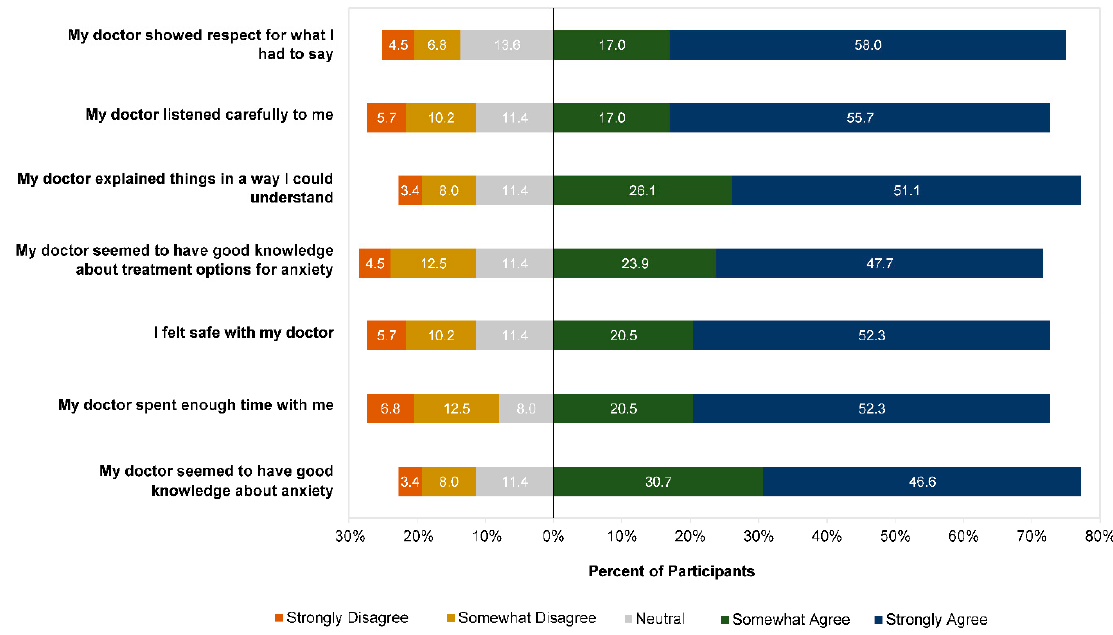
Figure 7. Participant ratings (n = 88) of perceptions of GP in the last 12 months. The results of the principal components analysis found the same single factor model for perceptions of GP at 12 months, which accounted for 81.2% of the variance. Com- posite scores were calculated, and the mean overall score for perceptions of GP was 28.47 (SD = 7.66). The results of the hierarchical linear regression found that the